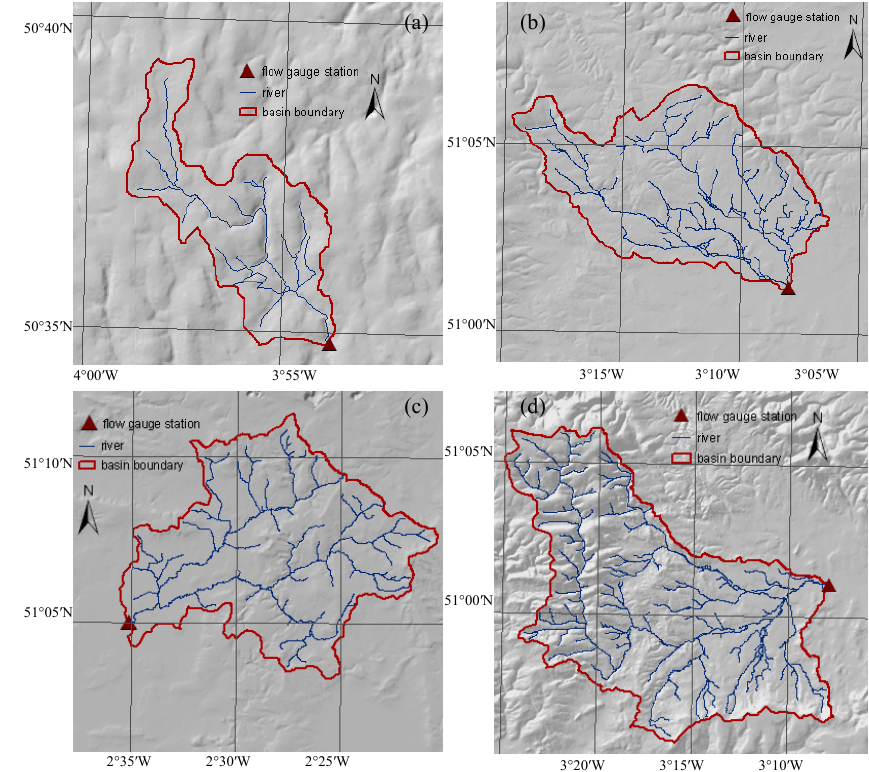
Figure 4 Locations and configurations of the four UK catchments in case studies with river networks and the flow gauging stations at the catchment outlets: (a) Bellever, (b) Halsewater, (c) Brue and (d) Bishop_Hull. Table 4. Flow gauge locations and values of the FEH catchment descriptors for the four catchments in the case studies. (A) (D) Bellever Flow gauge